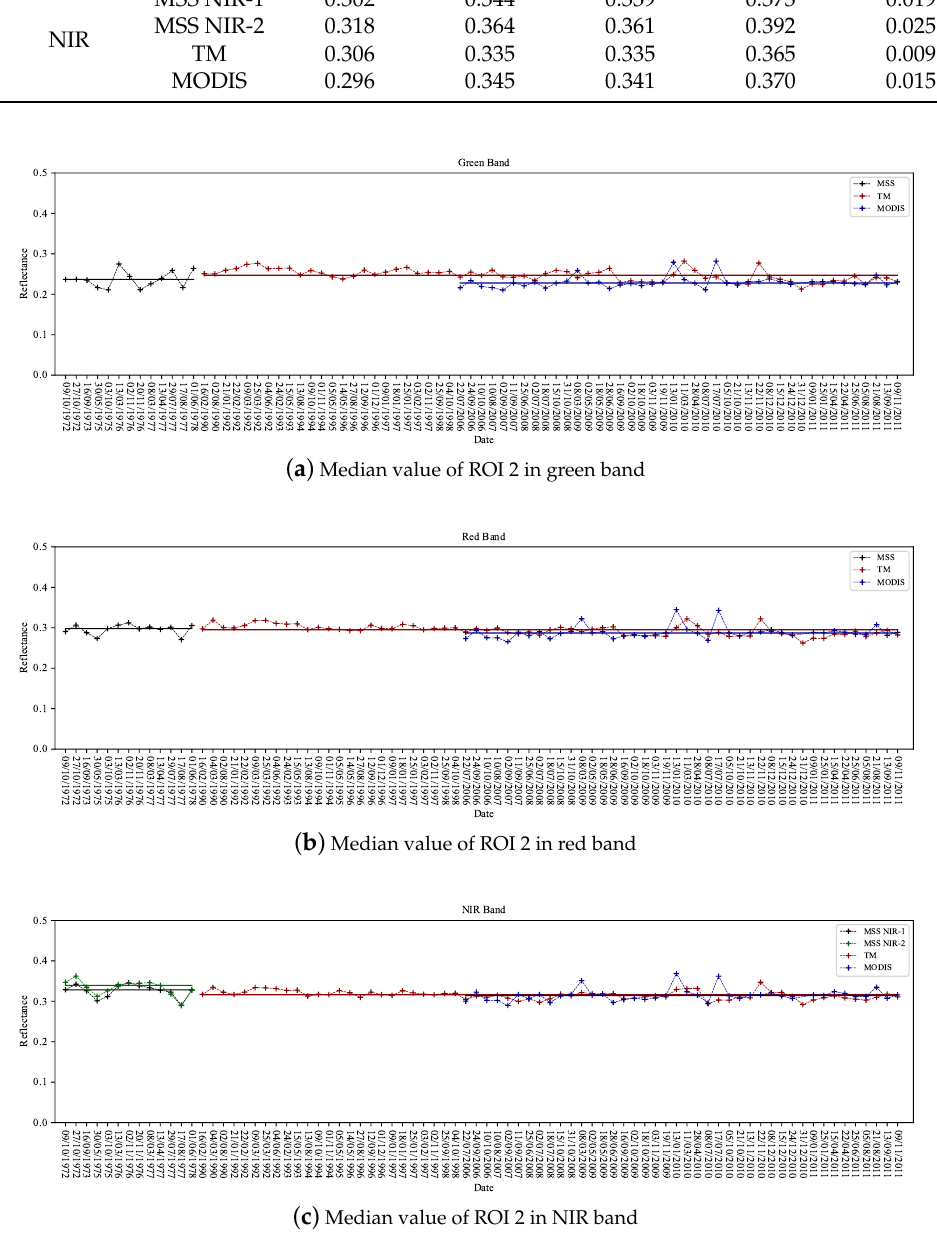
Figure 12. Time series of ROI 2 median value (ROI 2: